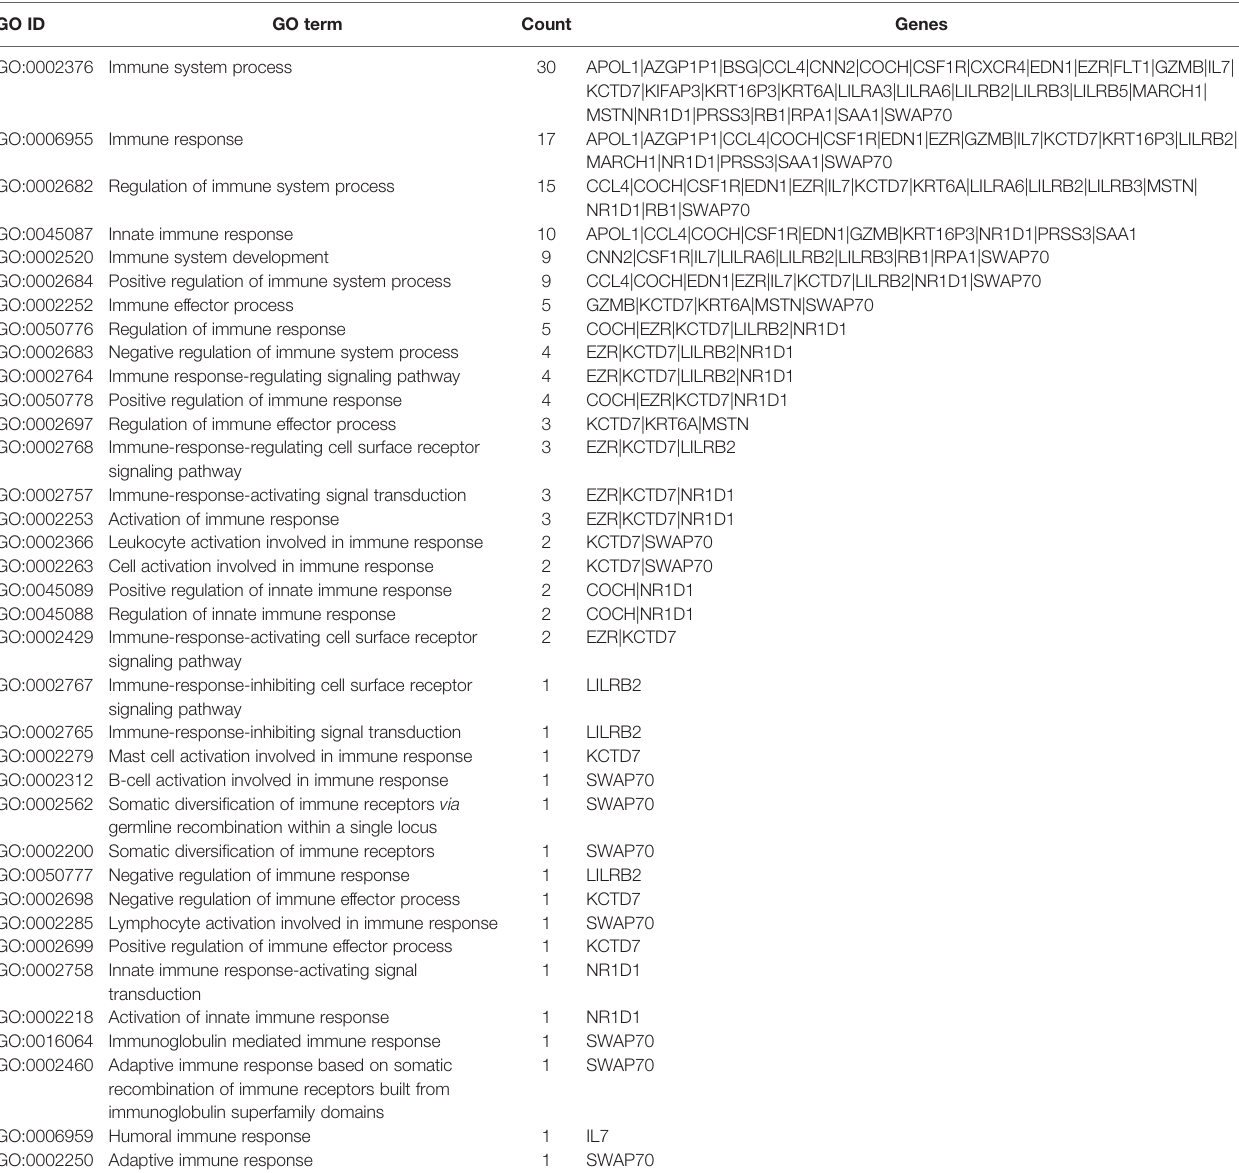
TABLE 1 | Gene Ontology terms associated with “ immune ” in Cluster Pro fi ler